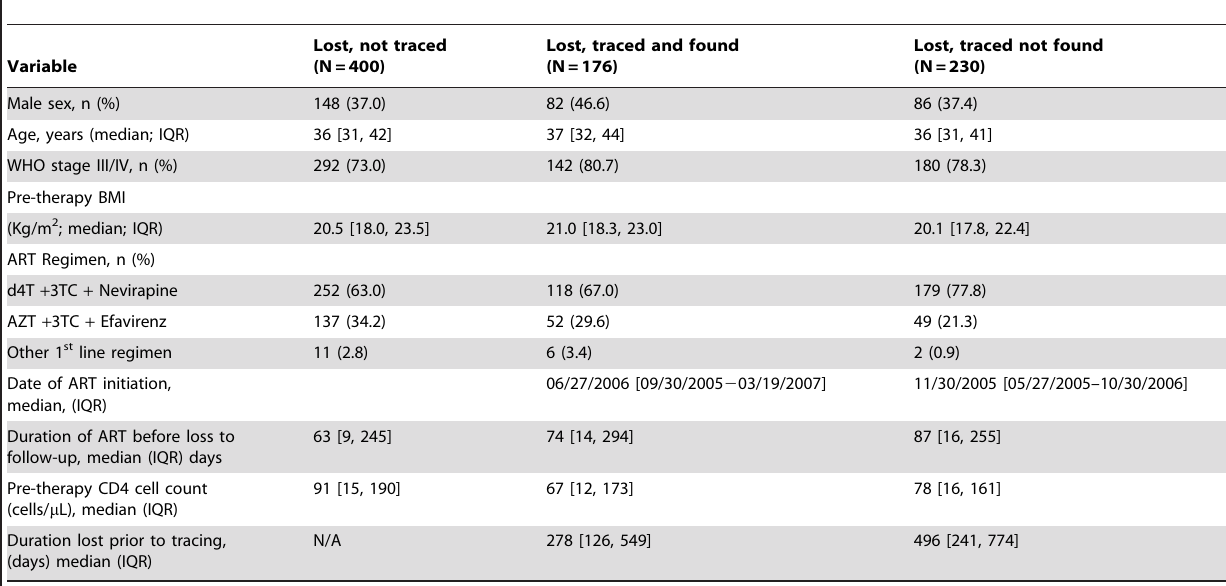
Table 2. Differences between patients lost and not traced, patients lost, traced and found and patients lost, traced and not found in the Routine Cohort.